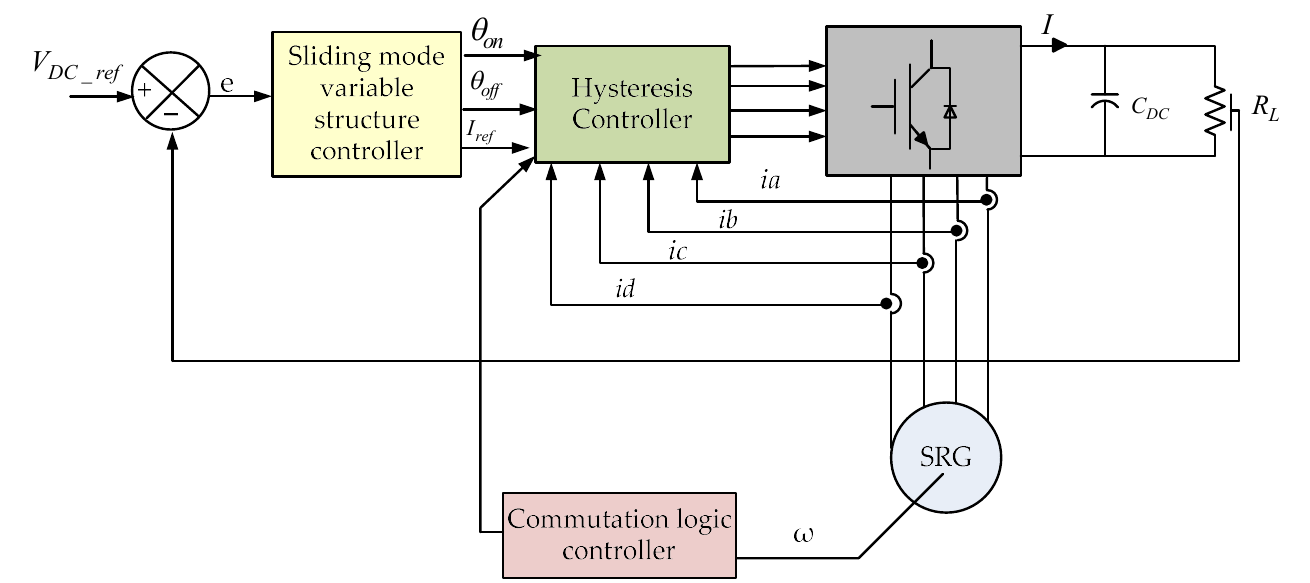
Figure 18. The bloc diagram of the sliding mode variable structure Controller.